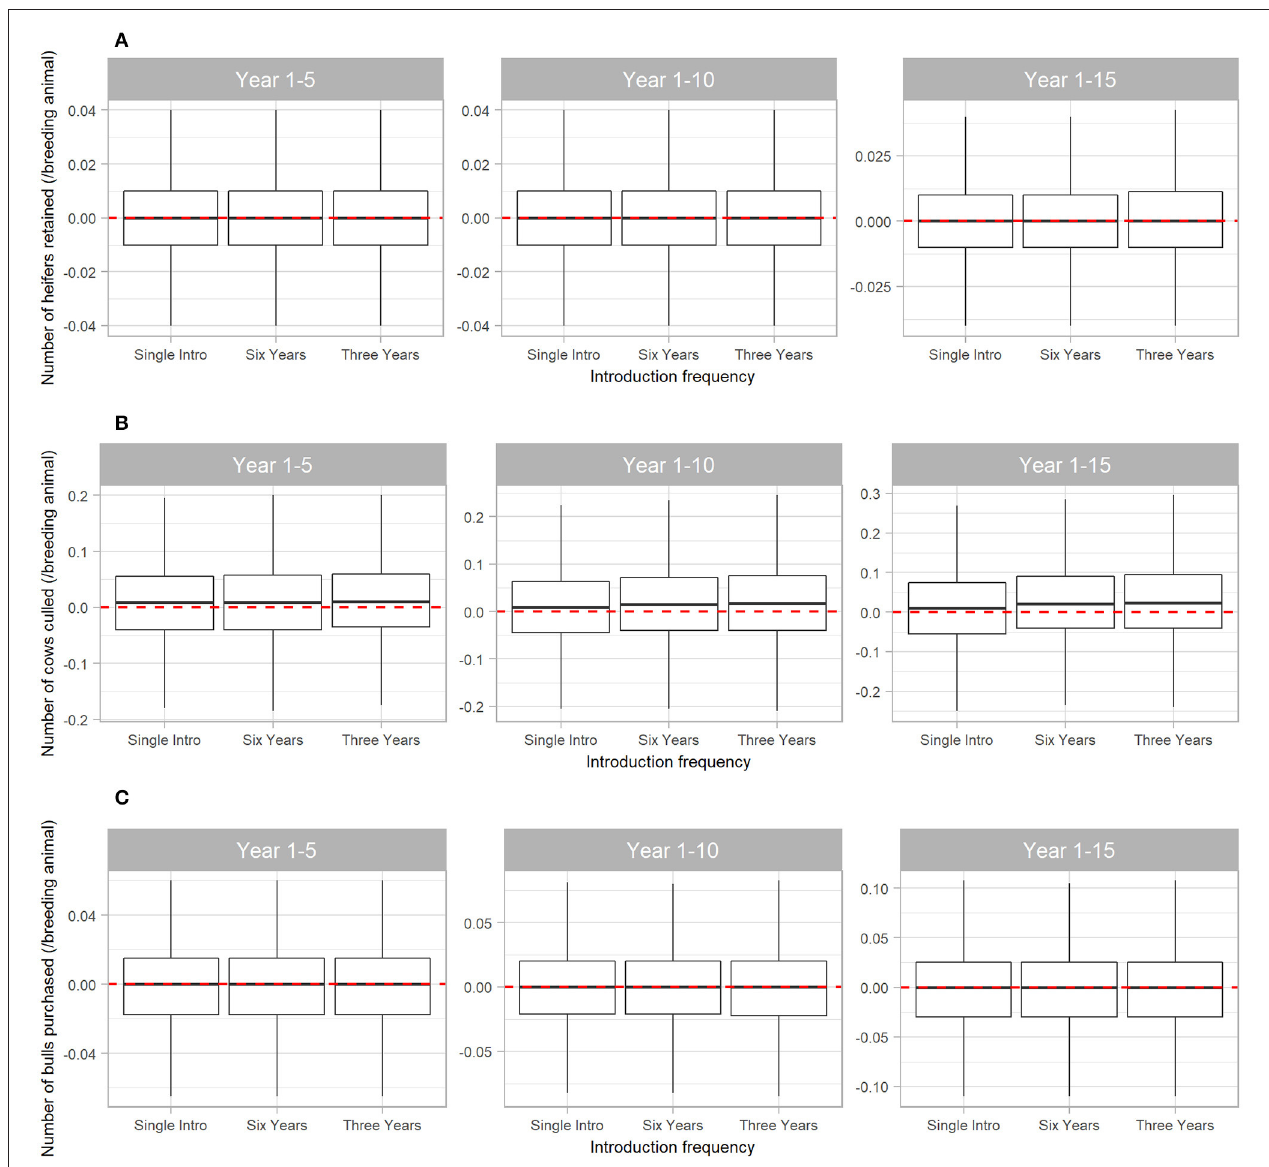
FIGURE 6 | Boxplot illustrating the cumulative effect of BVDV introduction frequency on economic outputs relating to reproduction animals in a simulated beef herd. The values depict the production loss in for BVDV introduction compared to a disease-free herd. The dotted red line highlights zero, which would represent “no difference” between the disease-free scenario and the scenarios with BVDV. Values either side of the line indicate the impact of BVDV on the number of heifers retained for breeding (A) , the number of cows culled (B) and the number of bulls purchased for replacement (C) /breeding animal. Boxes represent the 25 and 75% percentiles while whiskers represent the 2.5 and 97.5% percentiles. Outliers removed for improved scale and readability.